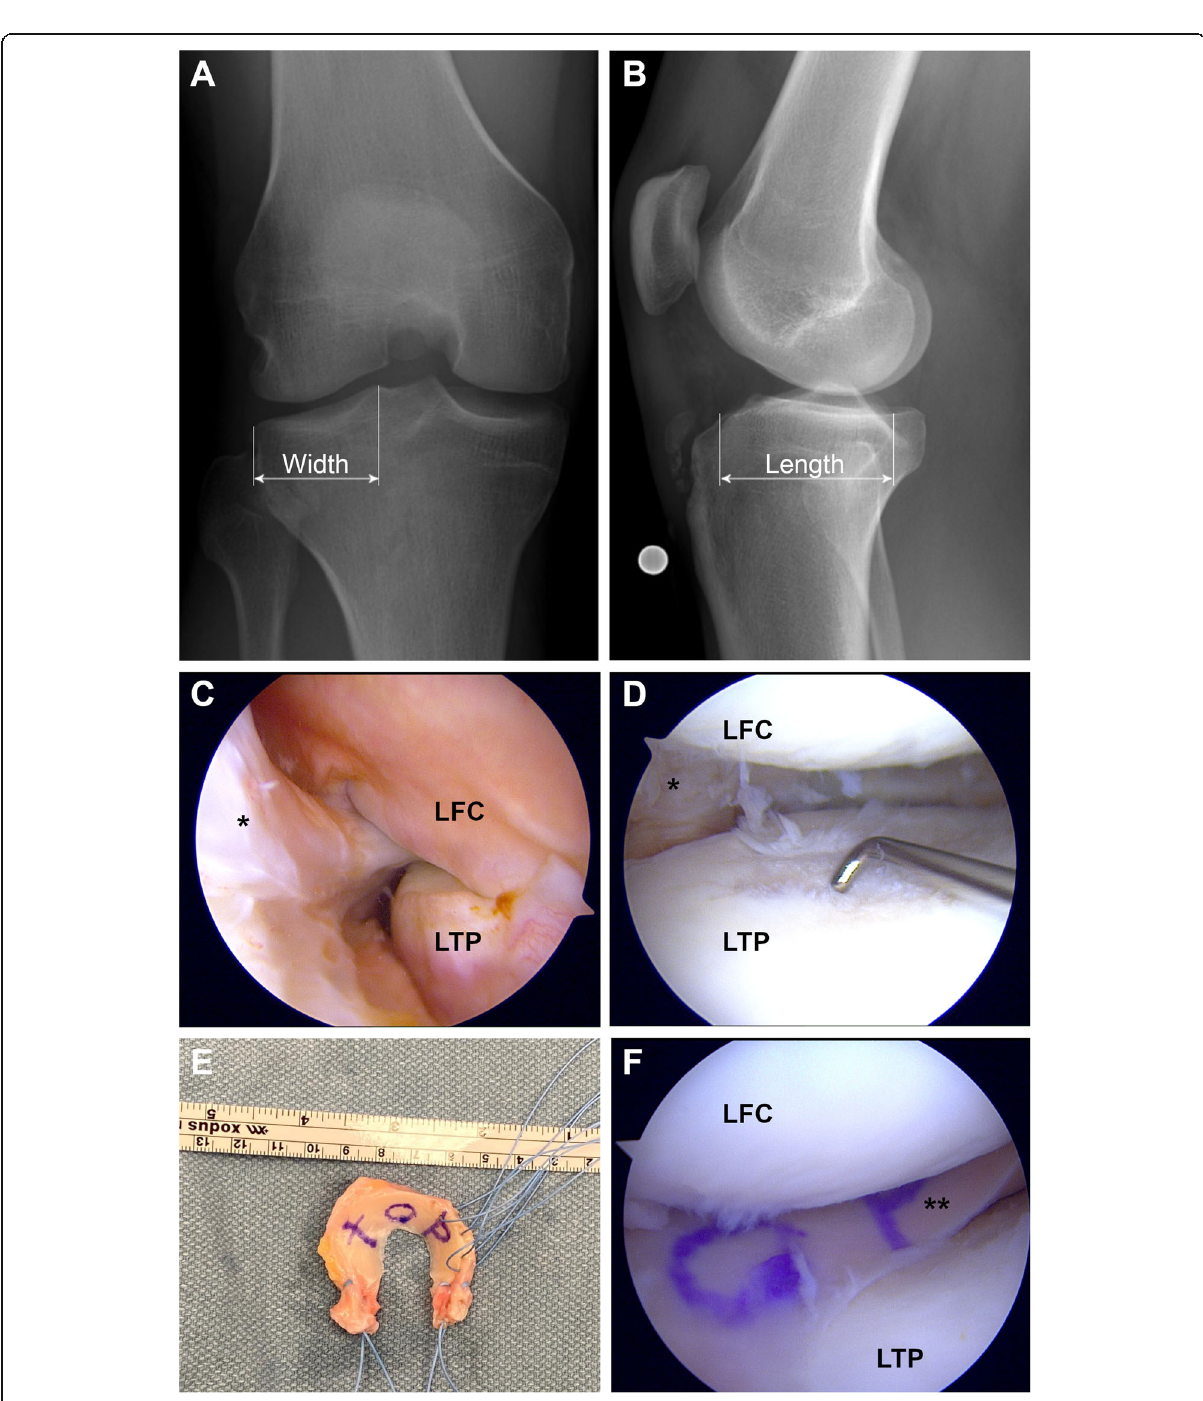
Fig. 2 Lateral meniscal allograft transplantation (MAT) by suture-only fixation technique in a patient having undergone subtotal lateral meniscectomy without rim preservation (right knee). Preoperative a) anterior-posterior (AP) and b) lateral radiographs for sizing of the meniscal allograft. The width is measured on the AP radiograph as the distance from the lateral border of the tibial plateau to the apex of the lateral tubercle of the intercondylar eminence. The length is determined as 70% of the measured length of the lateral tibial plateau [63]. c) Arthroscopic view of the lateral gutter. Note the absence of meniscal tissue between the lateral femoral condyle (LFC) and the lateral tibial plateau (LTP); d) Arthroscopic view of the lateral compartment with grade 2 femoral and tibial cartilage lesions; e) Lateral meniscal allograft after preparation and application of the fixation sutures; f) Arthroscopic view of the lateral compartment after lateral MAT; *,Remnant of the native lateral meniscus; **, Lateral meniscal allograft in